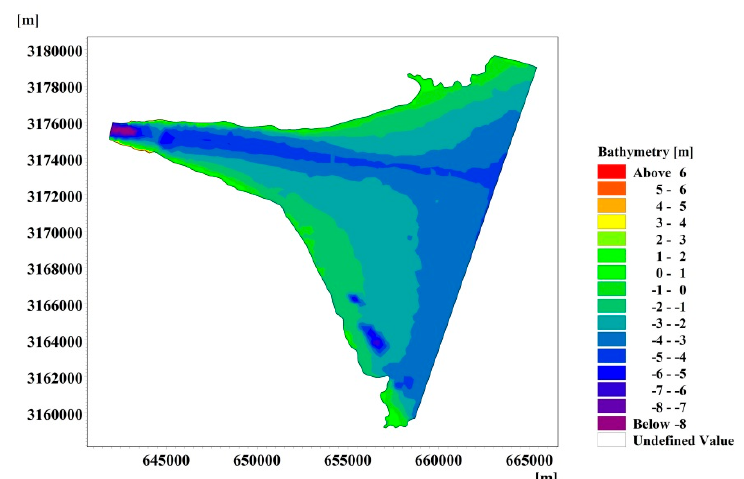
Water 2020 , 12 , x FOR PEER REVIEW Figure 3. Bathymetry of the calculation area.